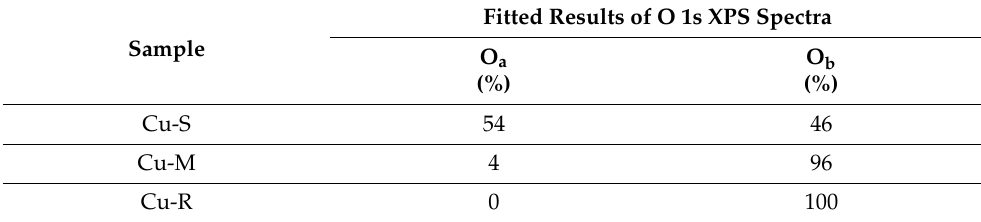
Figure 4. XPS spectra of Cu-R, Cu-M, and Cu-S ( a ) full survey, ( b ) O 1s, and ( c ) Cu 2p. Table 1. Fitted O 1s XPS spectra results of Cu-R, Cu-M, and Cu-S. Sample